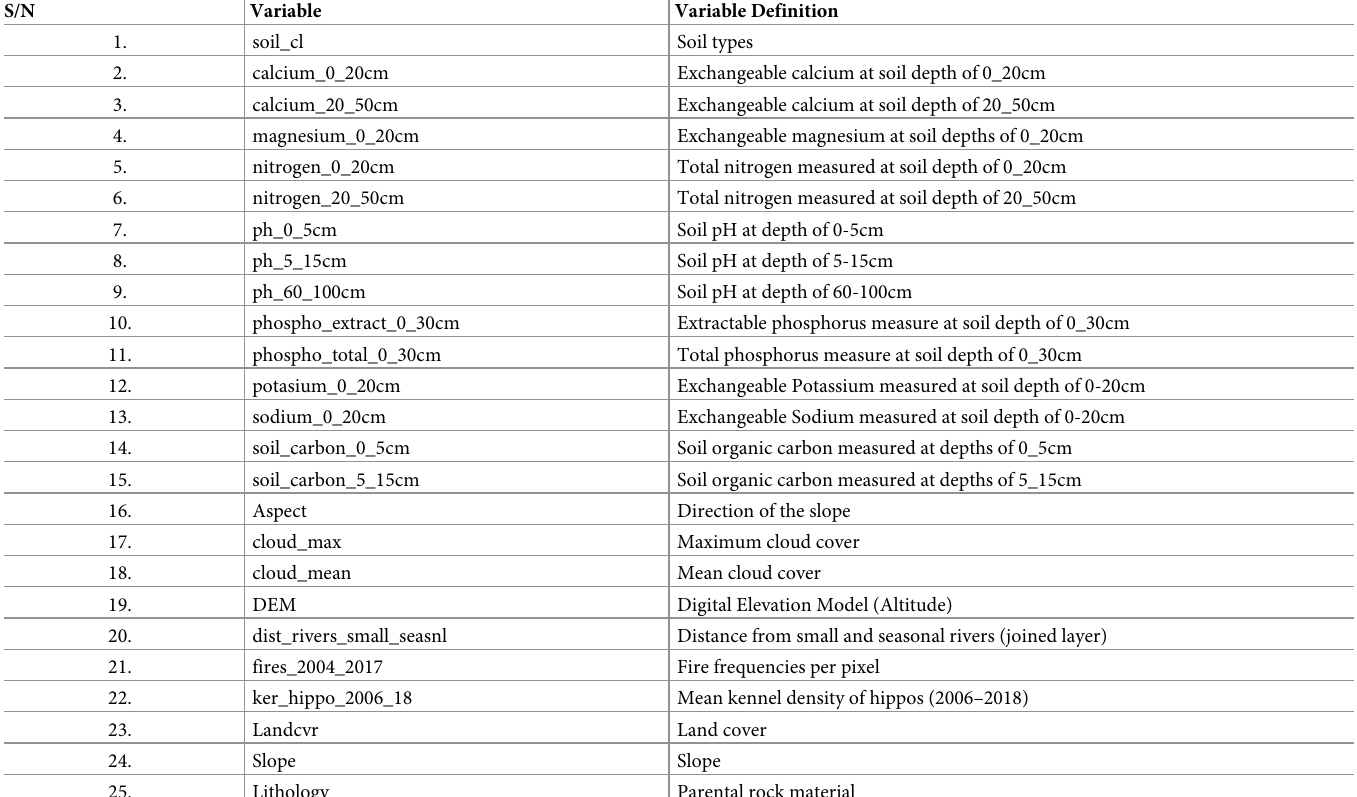
Table 2. Soil properties and geo-physical variables used for modeling suitable environmental conditions influencing anthrax distribution in QEPA.